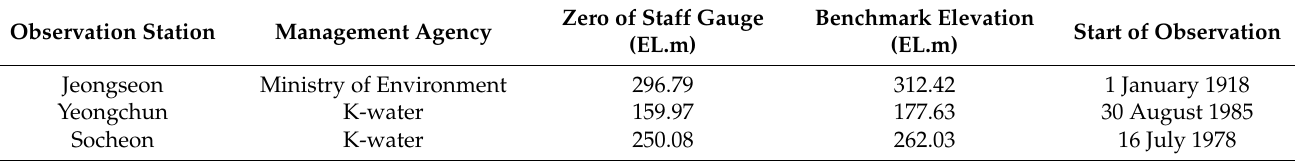
Table 4. Specifications of streamflow station (reprinted from